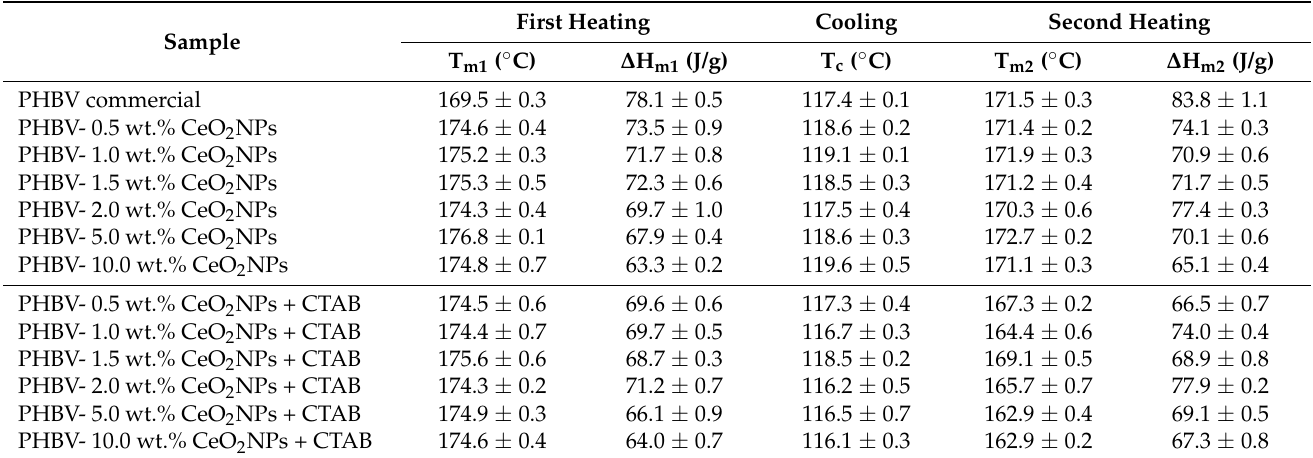
Table 2. Thermal characterization of electrospun poly(3-hydroxybutyrate-co-3-hydroxyvalerate) (PHBV) fibers containing cerium oxide nanoparticles (CeO 2 NPs) and hexadecyltrimethylammo- nium bromide (CTAB) in terms of crystallization temperature (T c ), melting temperature (T m ), and normalized enthalpy of melting ( ∆ H m